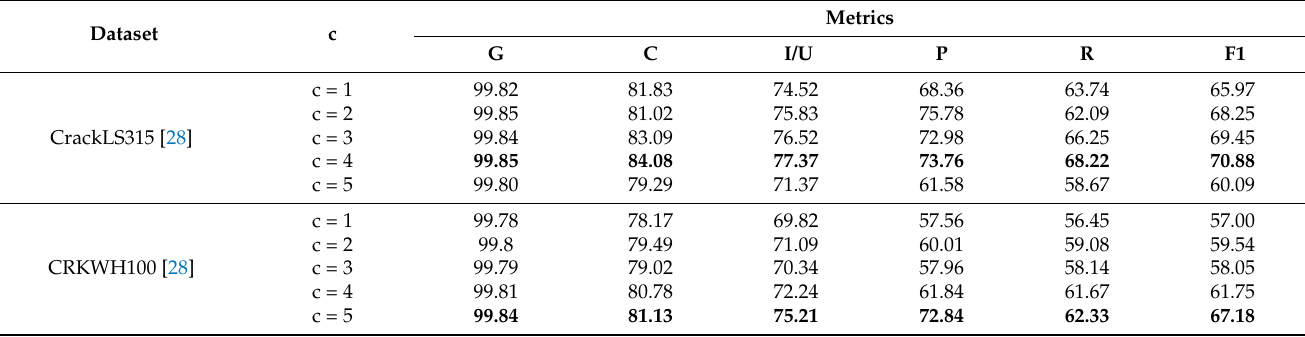
Table 5. The results of the number of the BT block layers on three datasets. The bold means that the best result for different block